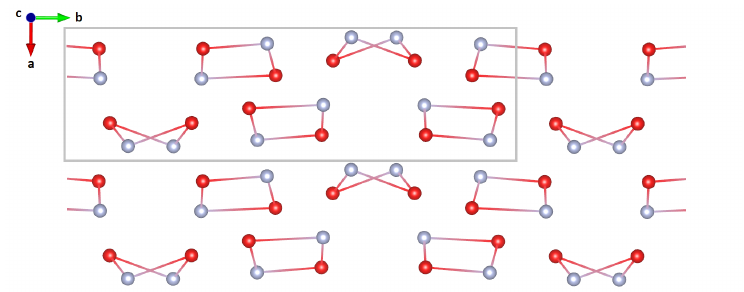
Figure 4. Reduced structure without hydrogen/deuterium along the unique axis (b-axis). The unit cell is indicated by a grey rectangle. Two structural motifs repeat along this axis, a planar quadrilateral and an ‘envelope shaped’